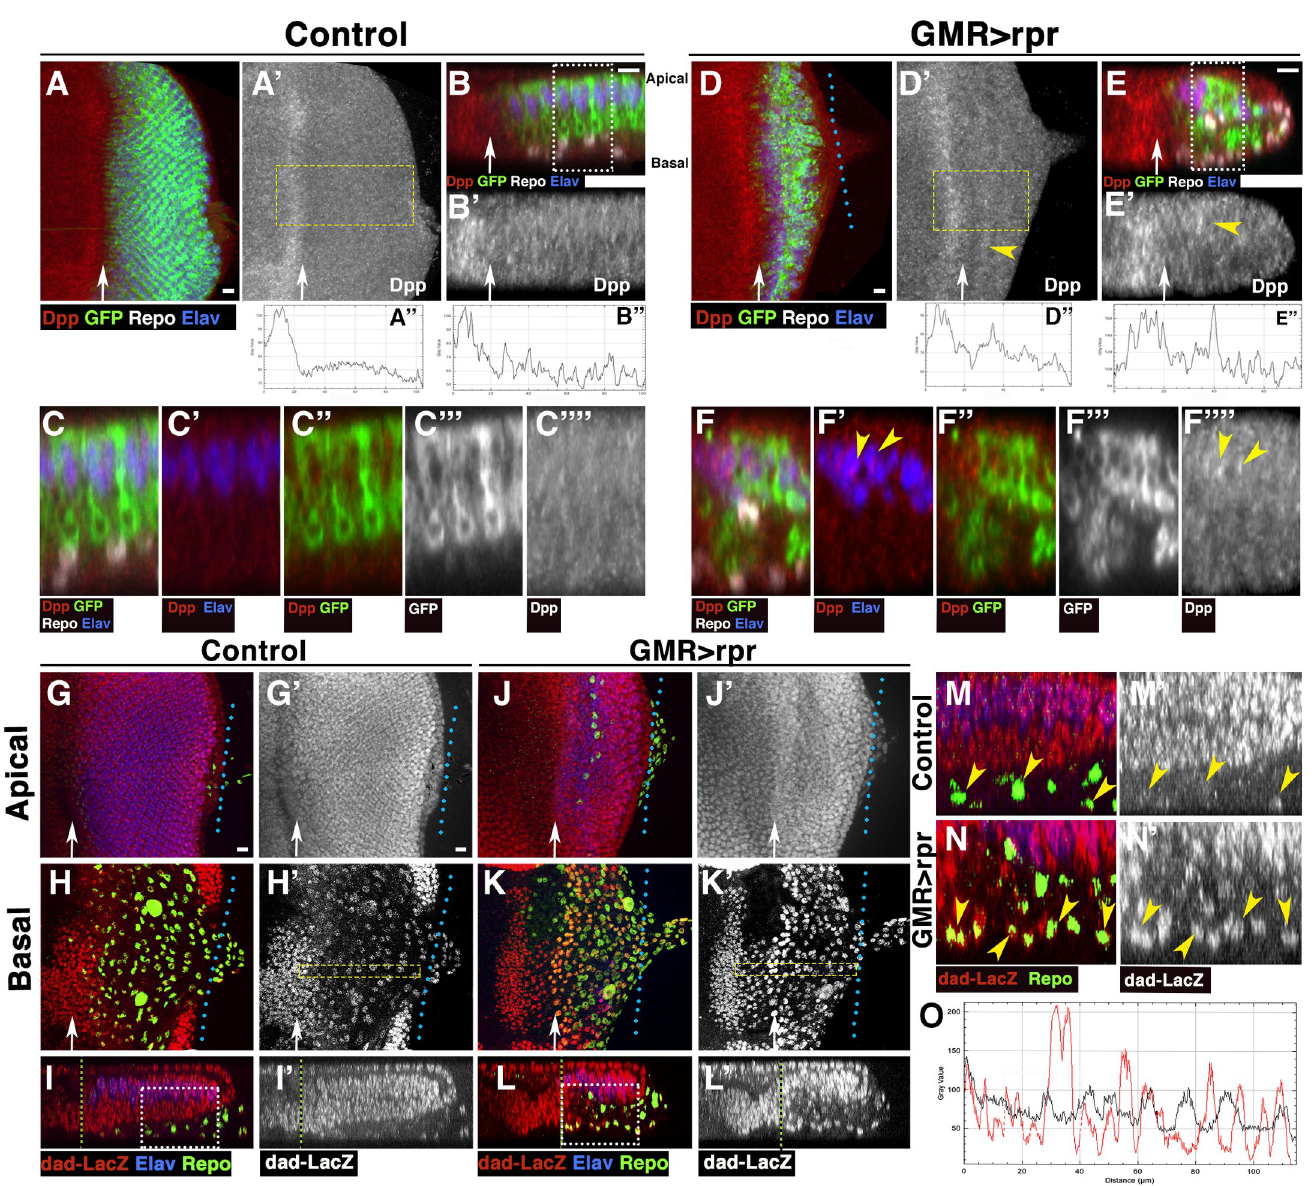
Fig 7. Dpp expression increases after inducing apoptosis in eye discs. (A–F””) Third instar eye discs stained with anti-Elav (Blue), anti-Repo (white in A–C and D–F), GMR-Gal4 UAS-mCD8-GFP (green in A–C, C”, D–F, and F” and grey in C”’ and F”’), and anti Dpp (red in A–C, C’, C”, D–F, F’, and F” and grey in A’, B’, C””, D’, E’, and F””), in control tub-Gal80 ts GMR-Gal4 UAS-mCD8-GFP (A–C””) and damaged UAS-rpr/+; GMR-Gal4 tub-Gal80 ts / UAS-mCD8-GFP discs (D–F””). (B–B’ and E–E) Cross sections perpendicular to the furrow of the eye discs shown in A (B–B’) and D (E–E’). (A” and D”) Profile plot of the average Dpp intensity across the x-axis of the region highlighted by yellow rectangles shown in panels A’ (A”) and D’ (D”). (B” and E”) Profile plot of the average Dpp intensity of the panels shown in B’ (B”) and E’ (E”). (C–C”” and F-F””) Higher magnification images corresponding to the regions highlighted by white rectangles on the panels B (C–C””) and E (F-F””). (A–B”) In control eye discs, Dpp is expressed in a band of cells just anterior to the MF, and its expression levels decrease abruptly to a homogeneous low level behind the furrow. (D–E”) In damaged discs, some photoreceptors (positive staining for anti-Elav in blue, yellow arrowheads in F’) express higher levels of Dpp than the surrounding cells (yellow arrowheads in F’ and F””). In the basal region of the epithelia, where most of the dead cells are located, we only detect low levels of Dpp expression. (G–N’) Third instar eye discs stained with anti-Elav (blue), anti-Repo (green), and anti-B-galactosidase (red in G–N and grey in G’–N’) to reveal the activity of the dad-lacZ reporter in control (GMR-Gal4 tub-Gal80 ts /+; dad-lacZ/+ ) (G–I’ and M–M’) and damaged UAS-rpr/+; GMR-Gal4 tub-Gal80 ts /+; dad-lacZ/+ discs (J–L’ and N–N’). (G–G’ and J–J’) Apical layers of the eye disc epithelium. (H–H’ and K–K’) Basal layers of the eye disc epithelium. (I–I’ and L–L’) Y–Z projections show 2 cross sections perpendicular to the furrow in control (I–I”) and damaged (L–L’) discs. (M–M’ and N–N’) Higher magnification images corresponding to the regions highlighted by white rectangles on the panels I (M–M’) and L (N–N’). Note that the levels of expression of dad- lacZ in glial cells of damaged discs (yellow arrowheads in N and N’) are much higher than in control discs (yellow arrowheads in M–M’). (O) Profile plot of the average β -galactosidase intensity across the x-axis of the region highlighted by yellow rectangles shown in panel H’ (control discs, black line) and K’ (damaged discs, red line). Arrow indicates the approximate position of the MF. The levels of expression of dad-lacZ are similar in control and damaged discs in the region anterior to